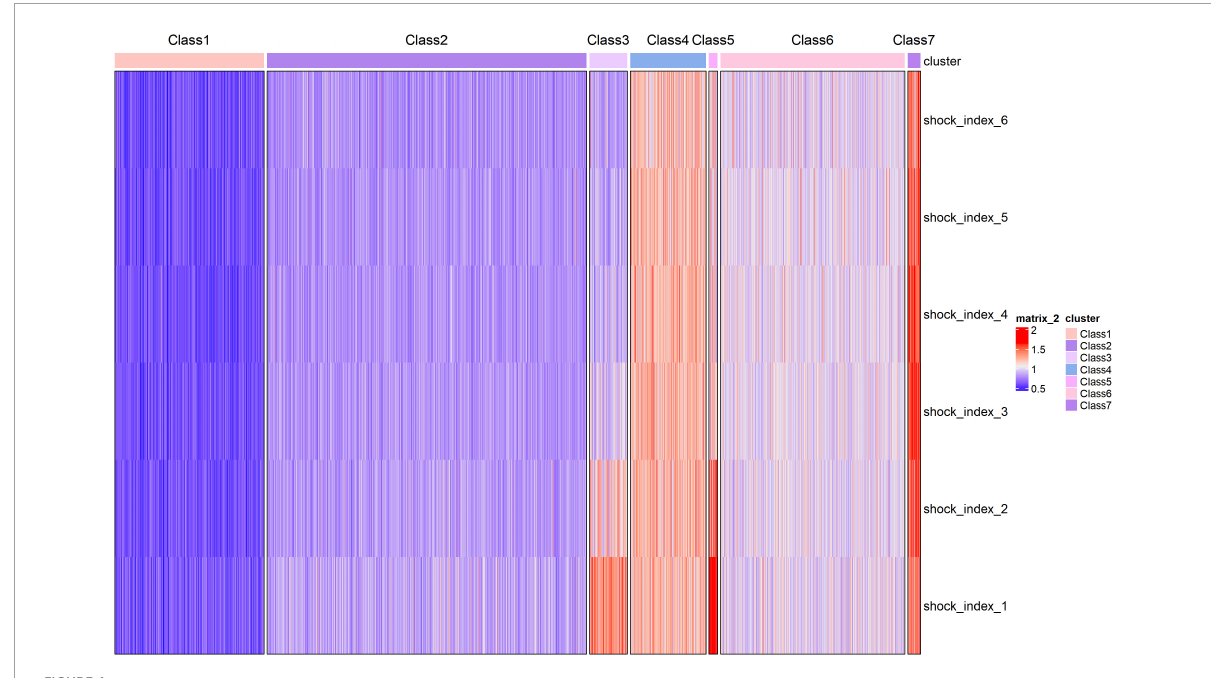
FIGURE4 Heatmap of shock index over time for the seven identified classes. Each patient is represented by a single line colored.